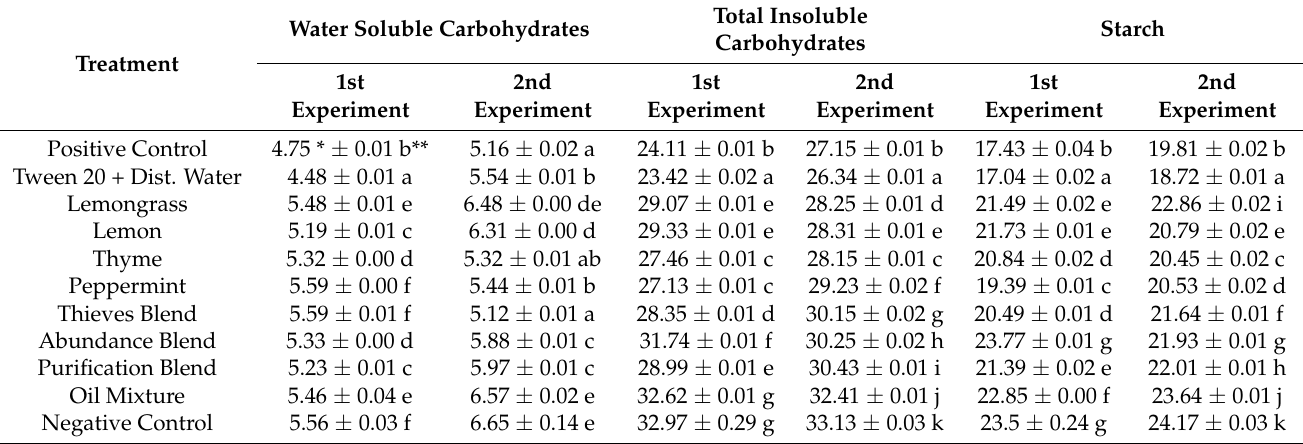
Table 5. Effect of treatment with essential oils (2.5 mL/L) on carbohydrate contents and starch formation (mg/g DW) in the cucumber plants under greenhouse